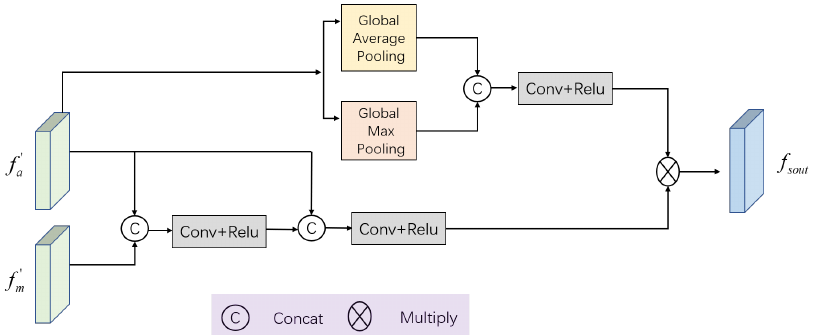
Figure 5. Block diagram of the Spatial attention